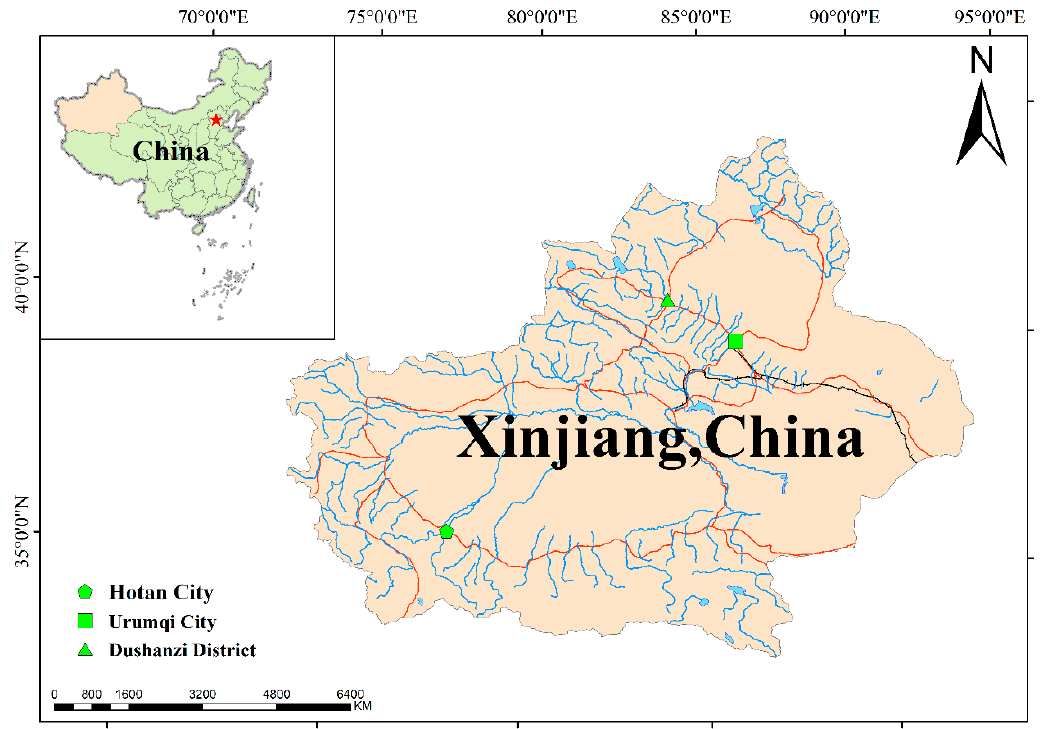
Figure 1. The geographical locations of Urumqi City, Hotan City, and Dushanzi District.